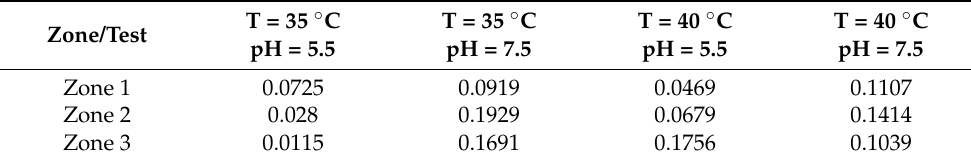
Table 3. Multifractal index by zone for the four experimental tests.